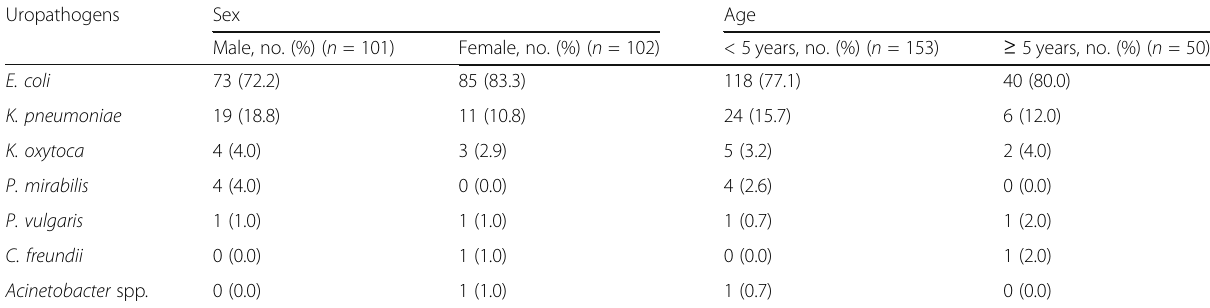
Table 1 Distributions of uropathogens by age and sex of children in Siddhi Memorial Hospital, Bhaktapur, Nepal Uropathogens